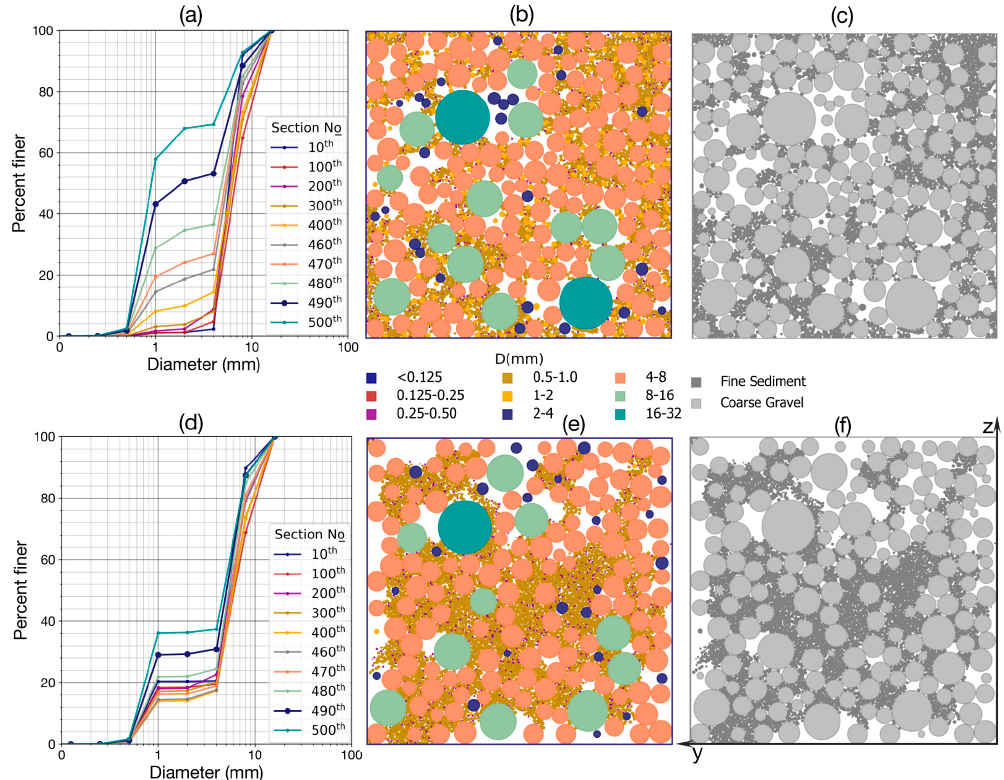
Figure 10. The cumulative grain-size distributions of bed materials at ten different represented cross-sections in z-direction ( a ) bridging, ( d ) percolation and bed structures at cross section 480th in z-direction, ( b ) Dataset-1, ( c ) Dataset-2, ( e ) Dataset-3, and ( f ) Dataset-4.